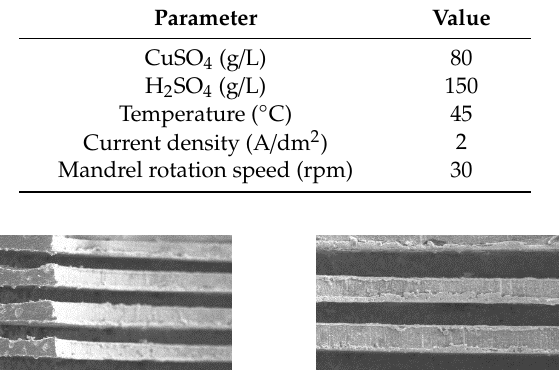
Figure 17. Schematic diagram of electroforming a corrugated horn. Table 2. Conditions for electroforming.